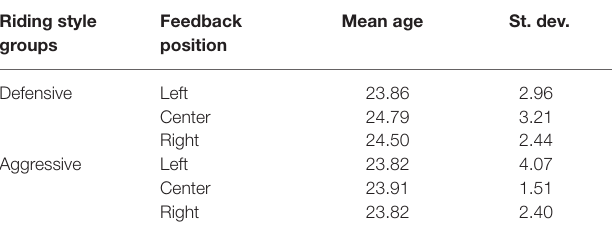
TABLE 1 | Means and standard deviations of age for each group.